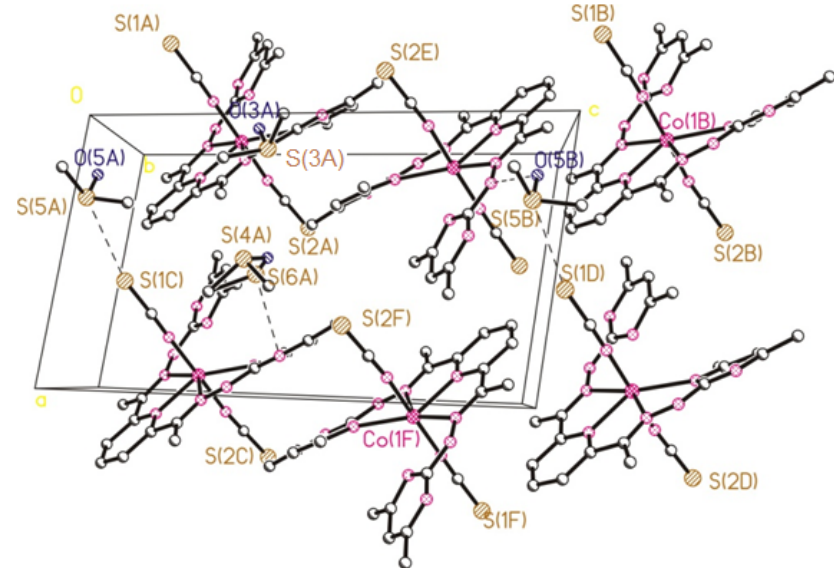
Figure 2. Fragment of the crystal packing in 1